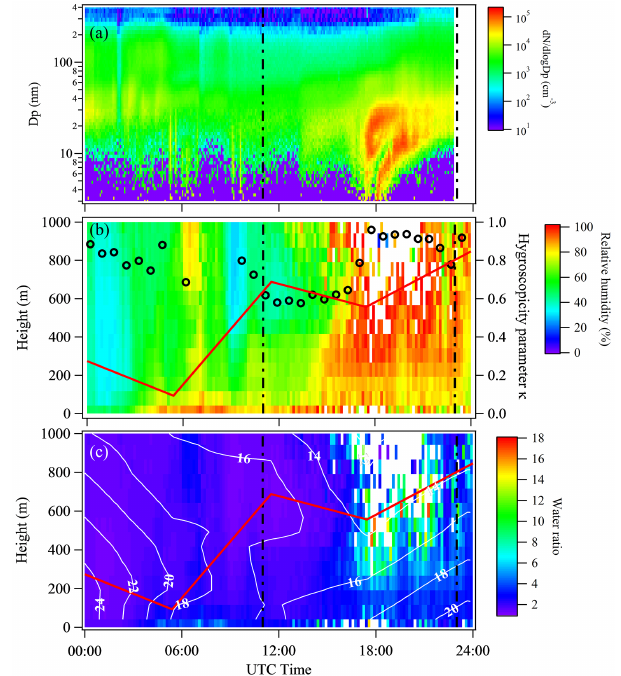
Figure 8. New particle formation event captured by scanning mo- bility particle sizers (a) , vertically and temporally resolved rela- tive humidity (b) , and estimated water volume ratio of 13nm parti- cles (c) on 9 May 2013 at SGP. The two vertical dashed lines in each plot represent 06:00 and 18:00 local time, respectively. The red line shows the boundary layer height determined from radiosonde data. Overlaid in the middle plot is the temporally resolved hygroscopic- ity parameter κ of 13nm particles obtained by TDMA (open black circles). Temperature ( ◦ C) is shown by the white contour lines in the lower plot.